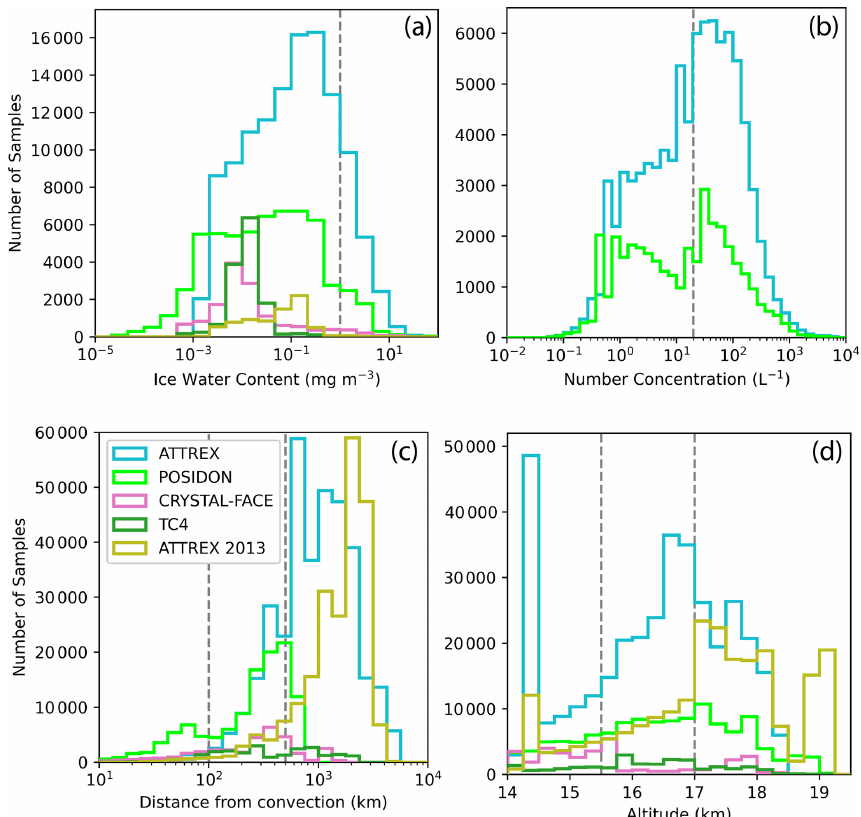
Figure B1. Histogram of (a) IWC, (b) NI, (c) distance from deep convection, and (d) altitude for all flight campaigns separately. NI is only shown for ATTREX 2014 and POSIDON. Dashed gray lines indicate boundaries used in the study to define categories.